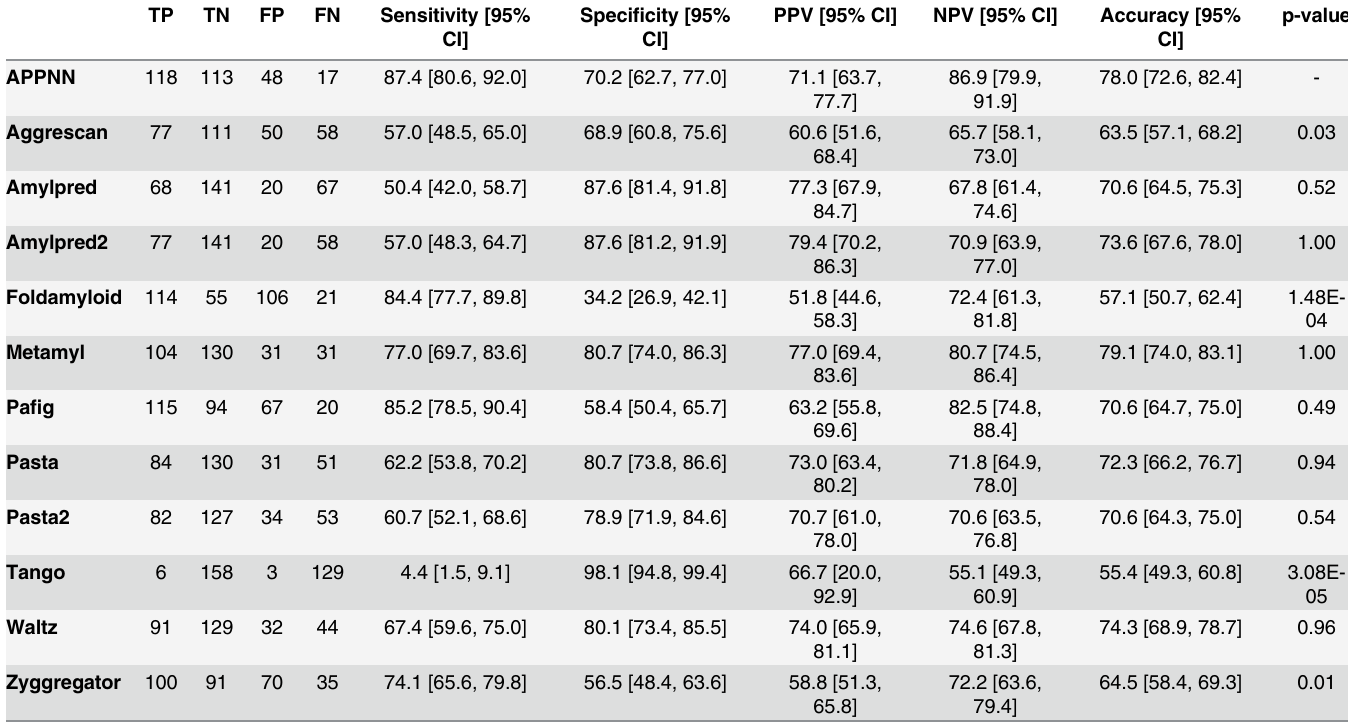
Table 3. Results obtained for the classification of the training sequences dataset for each predictor, where TP corresponds to the number of true positives, TN to the number of true negatives, FP to the number of false positives and FN to the number of false negatives. The values of sensitivity, specificity, positive predictive value (PPV), negative predictive value (NPV) and accuracy, with corresponding 95% confidence intervals, were obtained using bootstrap replicates. The p-value corresponds to the p-value obtained for the comparison of the accuracy values between the APPNN and each given other predictors using the Wilcoxon-Nemenyi-McDonald-Thompson post-hoc test performed after 10-fold stratified resampling.